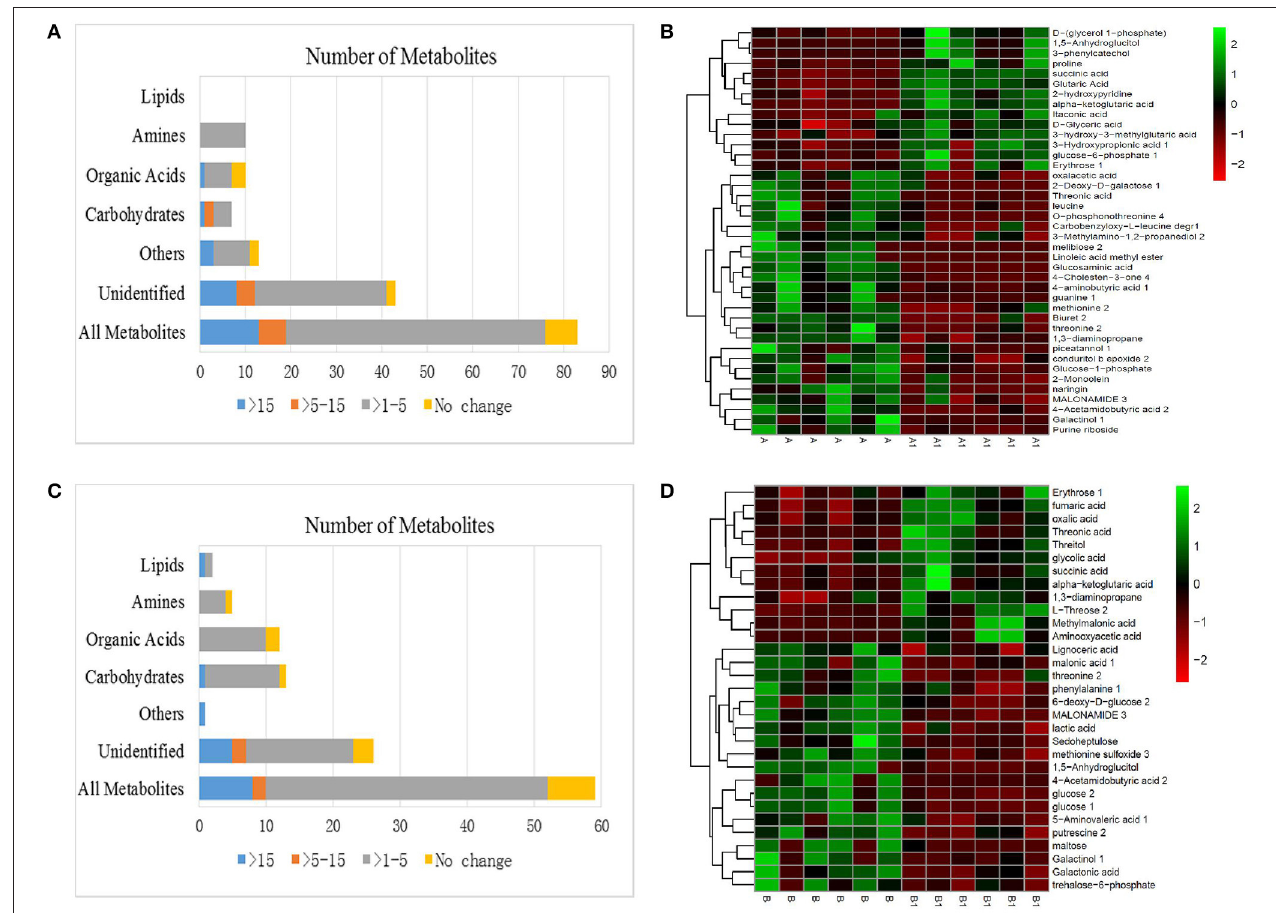
FIGURE 5 | (A) Effects of alkali stress on the metabolomes of NI. (B) Heat map analysis combined with hierarchical cluster analysis of A and A1. (C) Effects of alkali stress on the metabolomes of RI. (D) Heat map analysis combined with hierarchical cluster analysis of B and B1. A, NI control; A1, NI 6 d after alkali stress; B, RI control; B1, RI 6 d after alkali